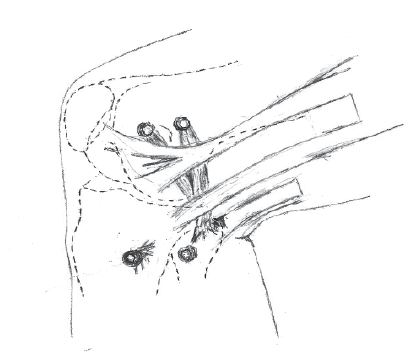
Figure 9 - Schematic drawing showing the final reconstruction of the posterolateral